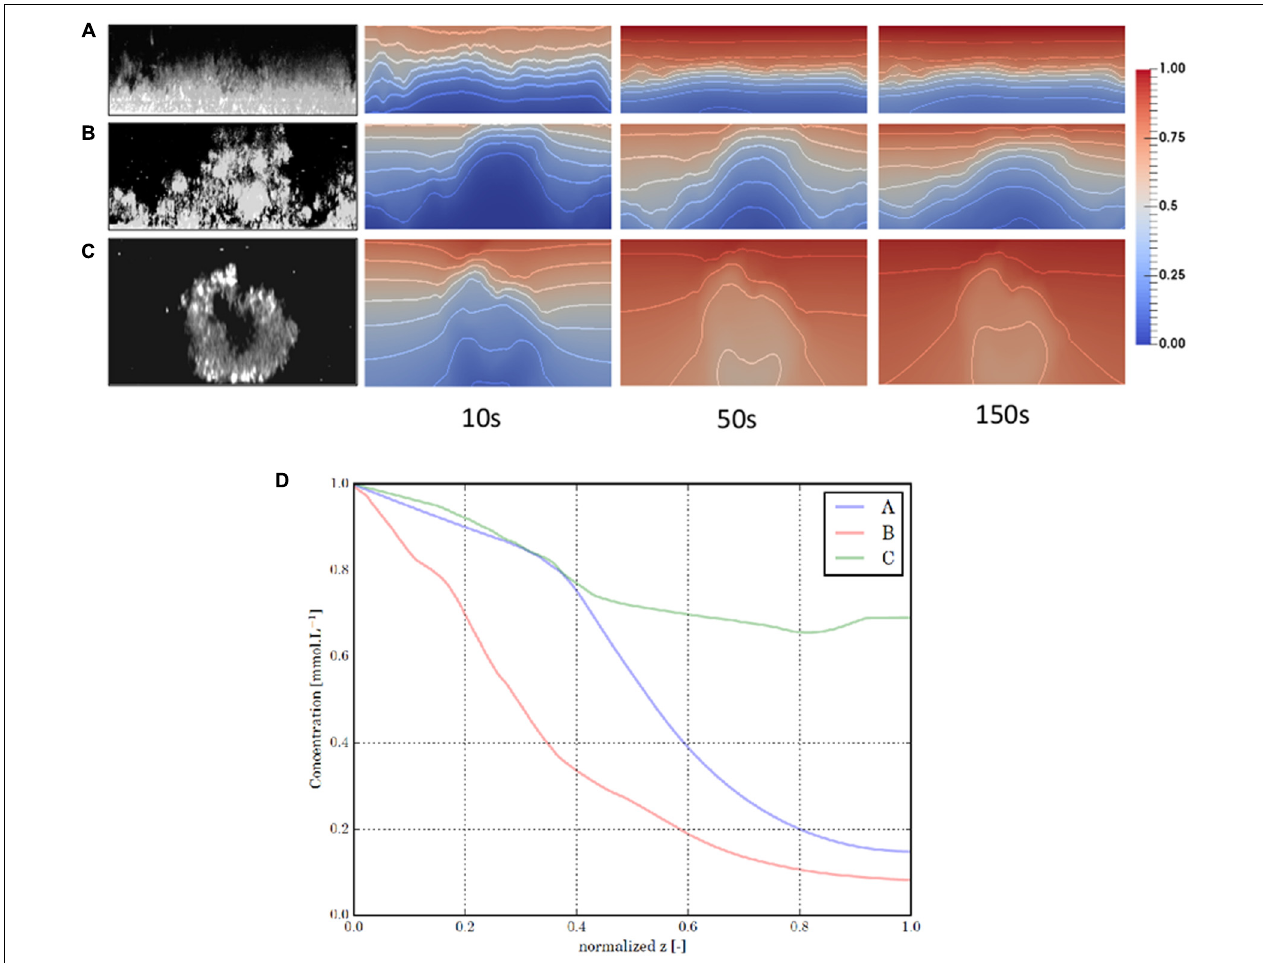
FIGURE 1 | Modeling of diffusion in biofilm of various architecture. CLSM sections of three characteristic biofilm structures were displayed in the first column: (A) a flat ( Escherichia coli ), (B) a mushroom-like ( Pseudomonas putida and Pseudomonas aeruginosa ) and (C) a egg-like structure ( Salmonella enterica ). Those images are used as an input of a modeling pipeline which simulates the diffusion of a chemical component through the biofilm, from a bulk source located in the upper boundary of the image. Based on the biofilm images, we construct for each structure a heterogeneous diffusion coefficient map that reflects the diffusive capabilities of the biofilm: the higher the local bacterial density, the lower the local diffusion coefficient. Next, this tensor is inserted in a reaction-diffusion equation together with a reaction function that mimics the consumption of the component by the bacteria. The consumption rate also varies with the local bacterial density. We display three snapshots of the simulated component distribution, at time t = 10, 50, and 150 s when the steady-state is reached. Isolines are displayed every 0.1 to better represent the distribution gradients. We finally display a cut in z of the component distribution in each biofilm at steady-state (D) . The cut plane of a given biofilm crosses its point of minimal component concentration at steady-state. To facilitate the comparison, we normalized the z-coordinates of the different graphs. We can see that the biofilm structure is a determinant driver of the component density map at steady-state, presenting a diversity of situation, from quasi-uniform distributions (structure C) to strong gradients (structures A and